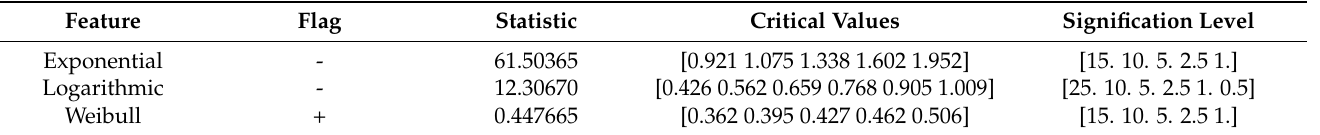
Table 11. Test results of three curve shape